Question: In a single sentence, describe what this figure presents.
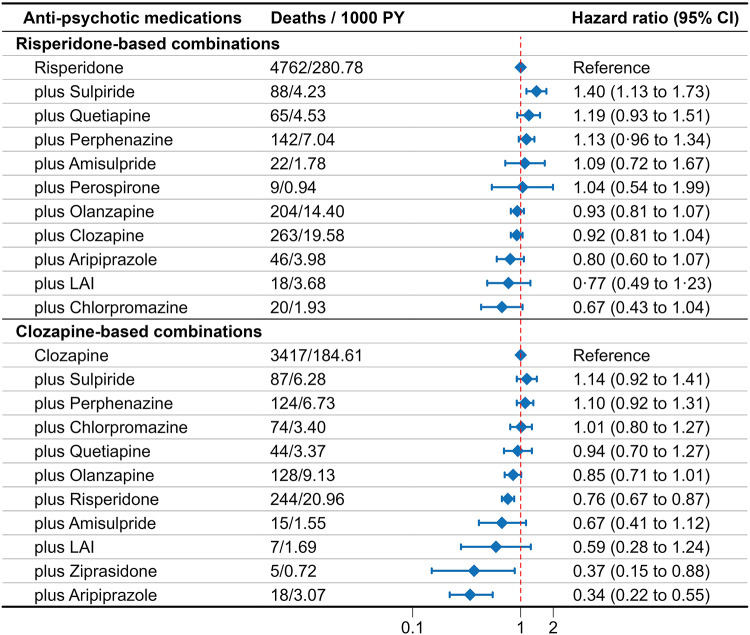
Answer: Associations between antipsychotic polytherapy combinations and mortality risk among schizophrenia patients receiving polytherapy. Cox proportional hazards regression models were used to estimate hazard ratios (HRs) and their corresponding 95% confidence intervals (CIs). PY, person-years. Adjusted HRs were controlled for age (continuous), sex (men or women), educational attainment (continuous), marital status (married or unmarried), poverty level (yes or no), region of residence (rural or urban), number of comorbid conditions (0, 1–2 or ≥3), frequency of suicide attempts or self-harm episodes (0, 1–2 or ≥3), presence of positive symptoms (yes or no), presence of negative symptoms (yes or no) and intensive mental health management (yes or no). Figure 3 long description.